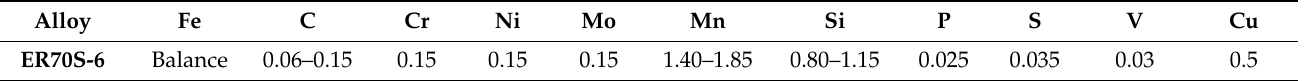
Table 1. Wire chemical composition [14] (All single values are maximums).